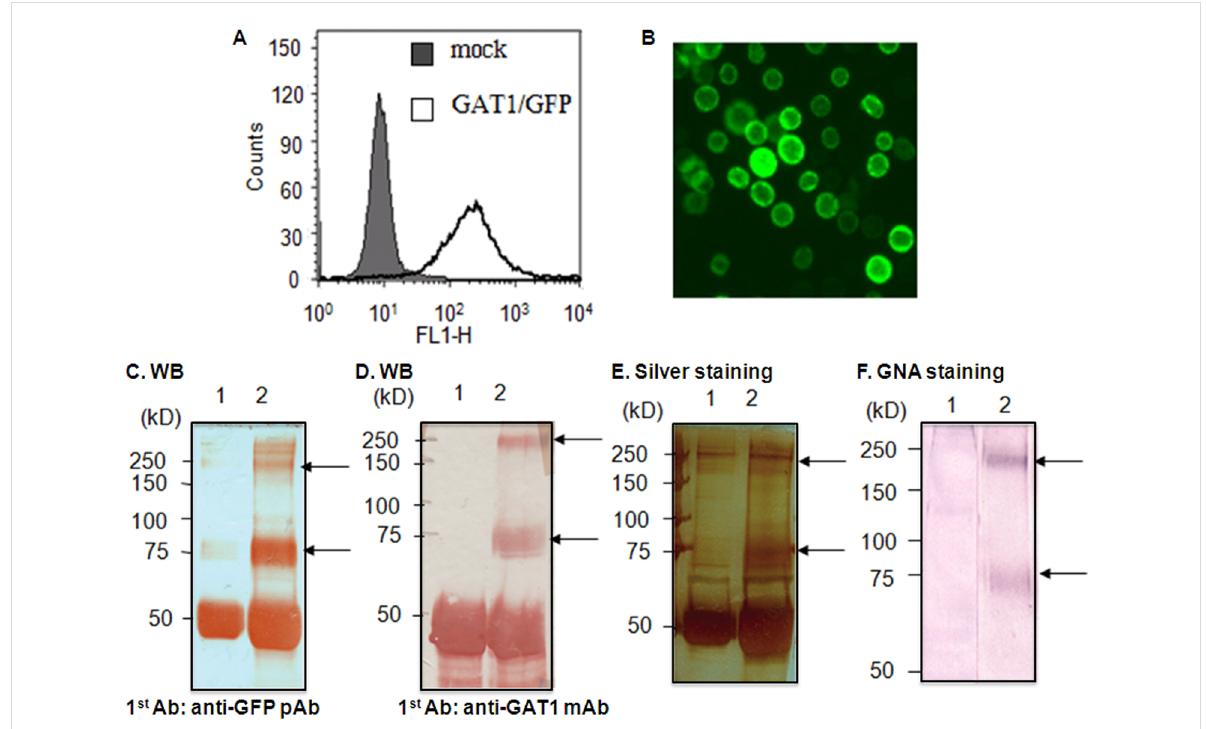
Figure 1: Expression of GFP-tagged GAT1 in infected insect cells. (A) Flow cytometry analysis of GAT1/GFP in Sf 9 cells. (B) Fluorescence microsco- py of infected Sf 9 cells. The GFP fluorescence in the GAT1/GFP fusion protein was detected. The solubilized proteins of infected Sf 9 cells were sub- jected to immunoprecipitation with anti-GFP mAb IgG and then analyzed by SDS-PAGE (7.5%) and immunoblotting. (C) and (D) Western blotting analysis of GAT1/GFP from uninfected and infected Sf 9 cells with anti-GFP pAb or anti-GAT1 pAb. (E) Silver staining of GAT1/GFP from infected Sf 9 cells. (F) GNA staining of GAT1/GFP from infected Sf 9 cells. The main bands corresponding to the GAT1/GFP fusion protein are indicated with arrows; Sf 9 cells (lane 1), GAT1/GFP infected Sf 9 cells (lane